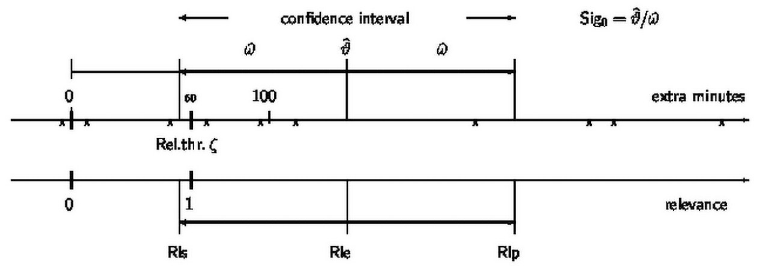
Fig 1. Estimate, confidence interval and relevance for the sleep